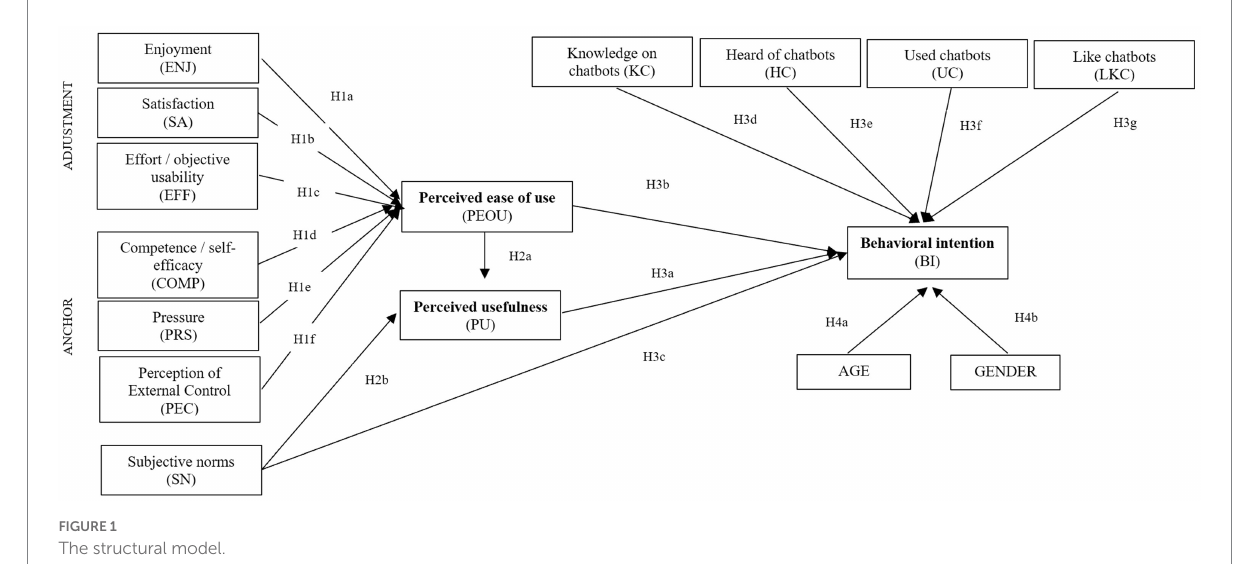
FIGURE 1 The structural model.